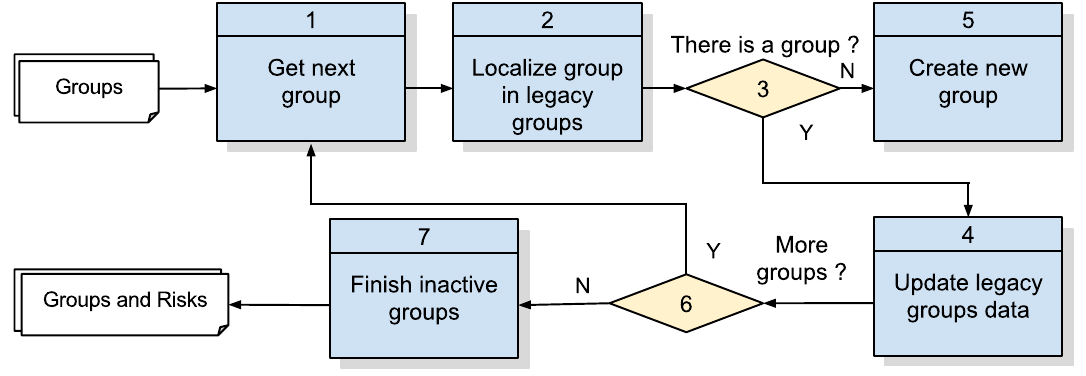
Figure 12. Algorithm 3: computation of risk indicators. Source: the